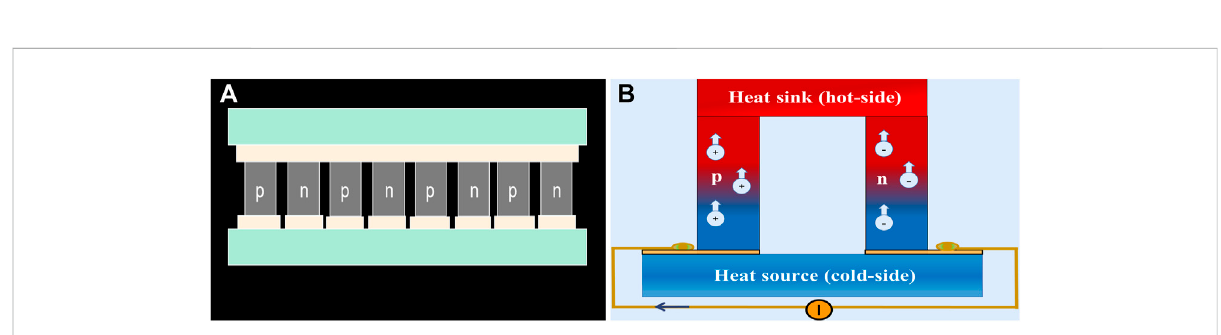
FIGURE 6 The construction and schematic diagram of TE materials. (A) TE materials consist of several thermocouples composed of p-type and n-type thermoelectric legs, which are electrically in series and thermally in parallel. (B) Once electric current is applied, charge carriers, electrons in n-type, and holes in p-type would transfer heat in the module from one side to the other (Kishore et al.,